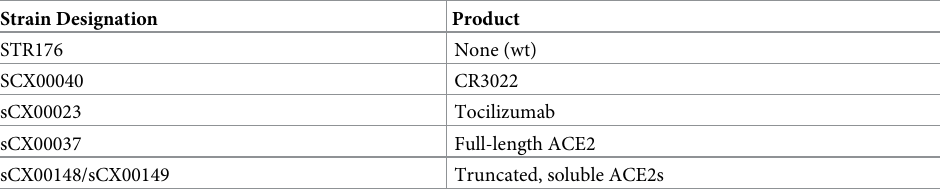
Table 1. Strains used to confirm production of monoclonal antibodies and